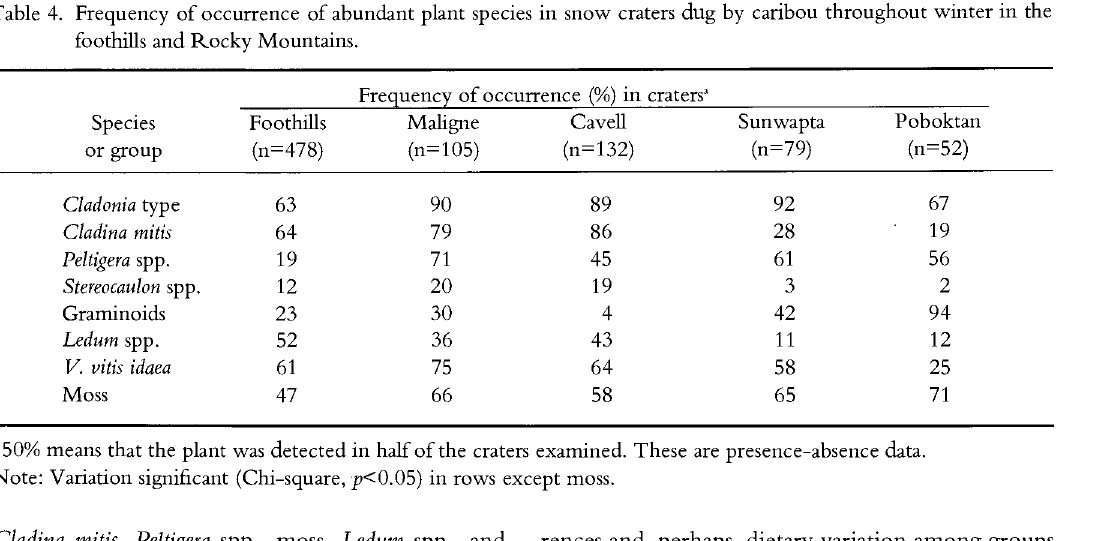
Table 4. Frequency of occurrence of abundant plant species in snow craters dug by caribou throughout winter in the foothills and Rocky Mountains.